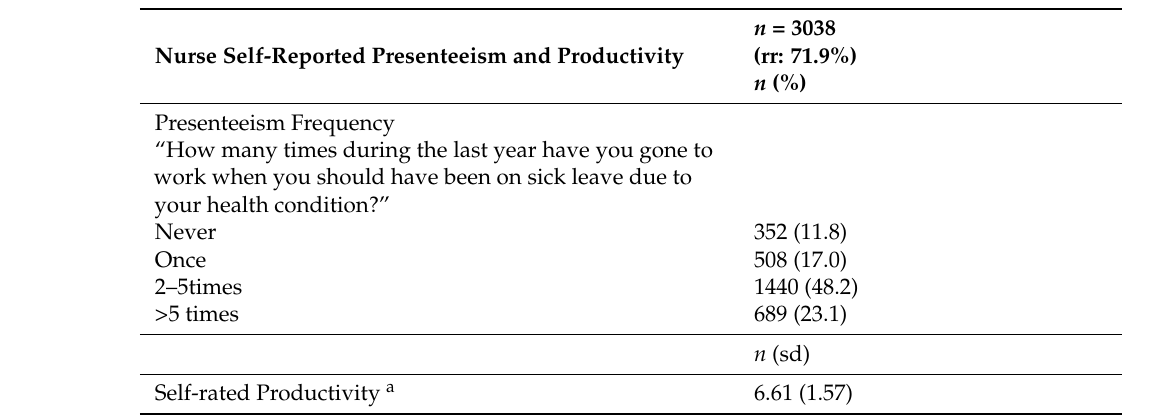
Table 3. Nurse self-reported presenteeism and